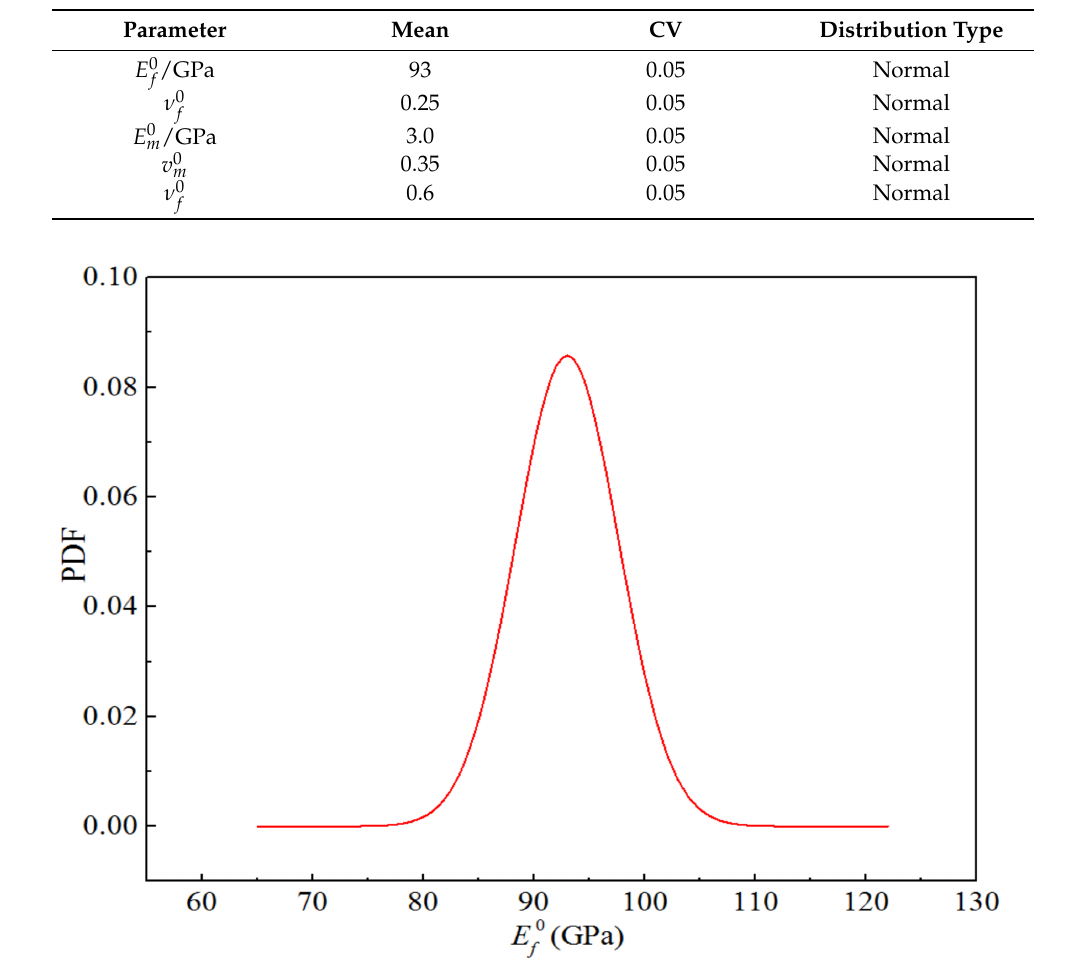
Table 14. Statistical model of the material properties in the RTD state.